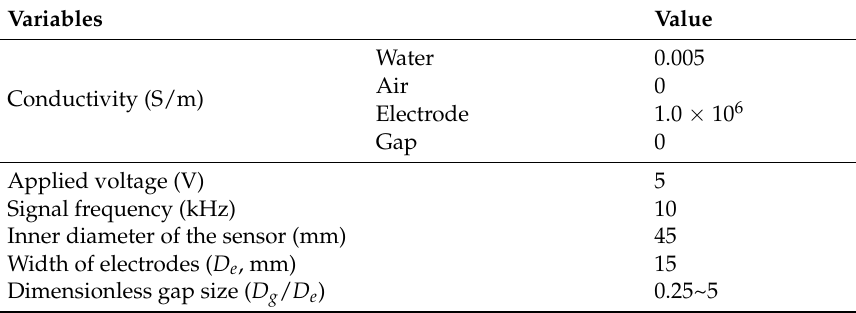
Table 1. Electrical properties and sensor dimensions for the numerical